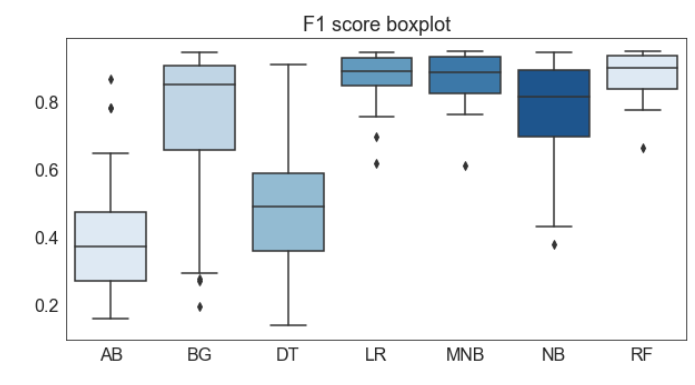
Figure 13. Precision boxplot.